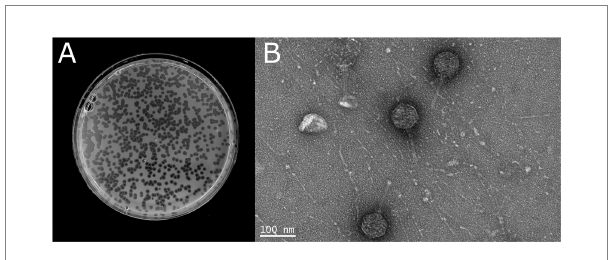
FIGURE 6 (A) Morphology of the plaques produced by the phage Larrie. (B) Phage particles negatively stained and observed with TEM.